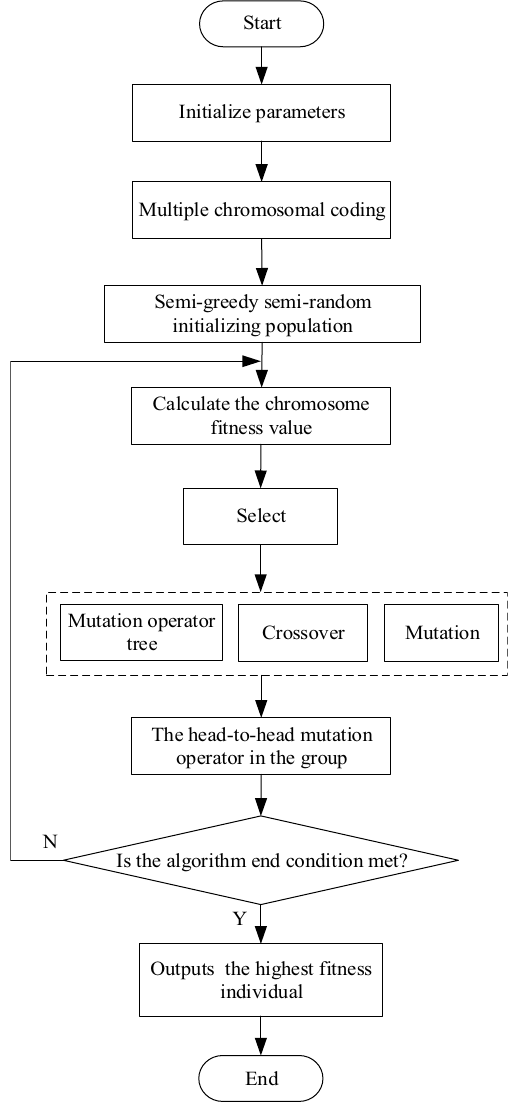
Fig. 1 Flowchart of improved genetic